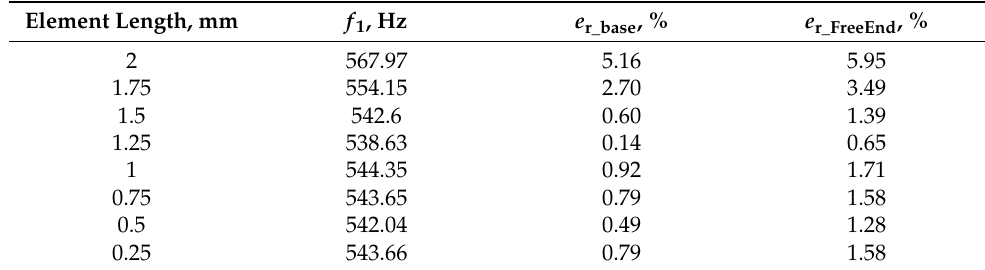
Table 5. Mesh sensitivity analysis for tetrahedral elements with glued